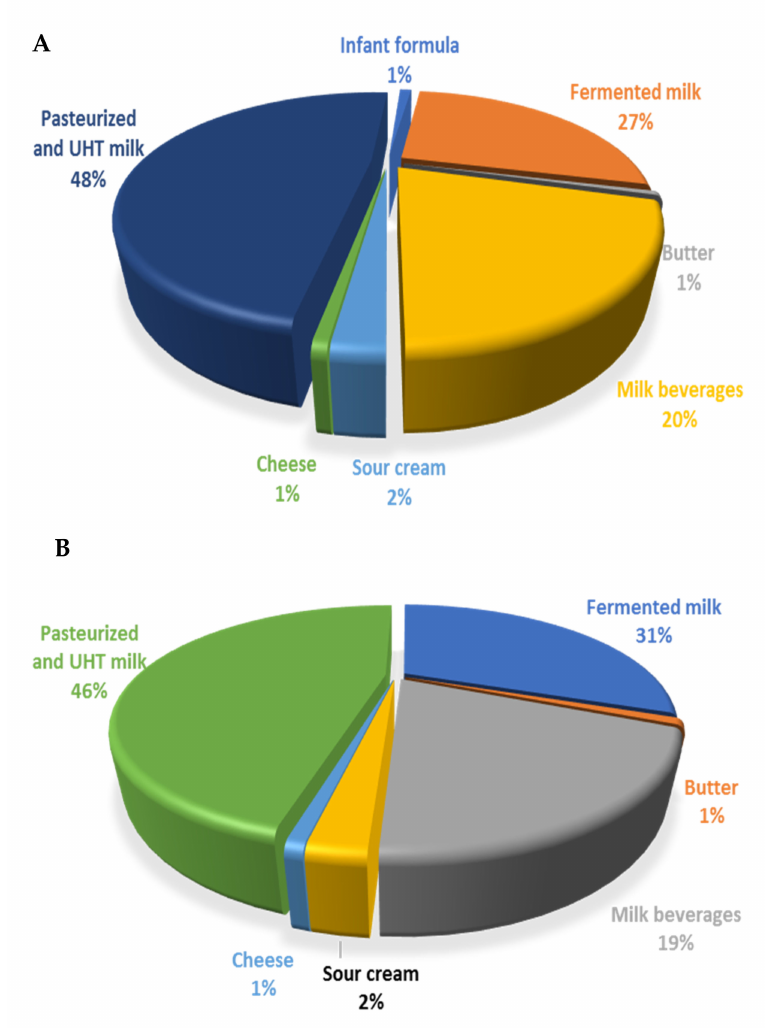
Figure 1. Contribution (%) of the most important food groups to the long-term dietary exposure of children aged 2 to 6 years ( A ) and toddlers, 1–3 years ( B ), to